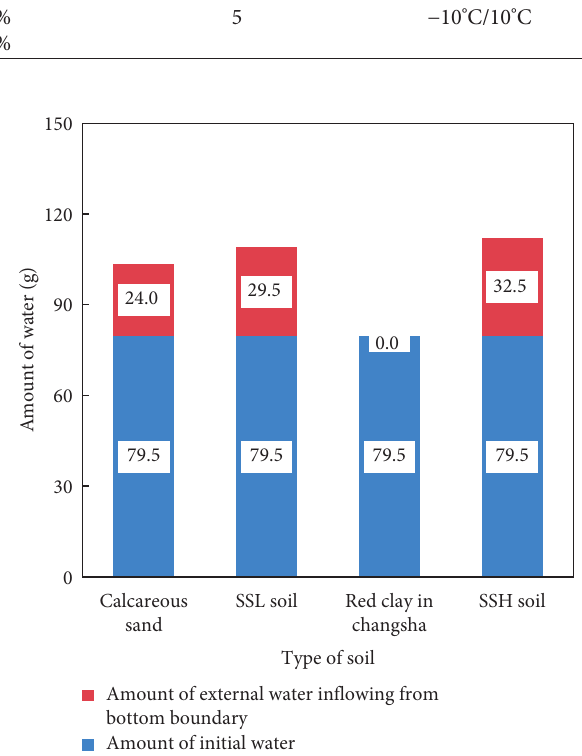
Figure 3: Amount of water in samples of different soil